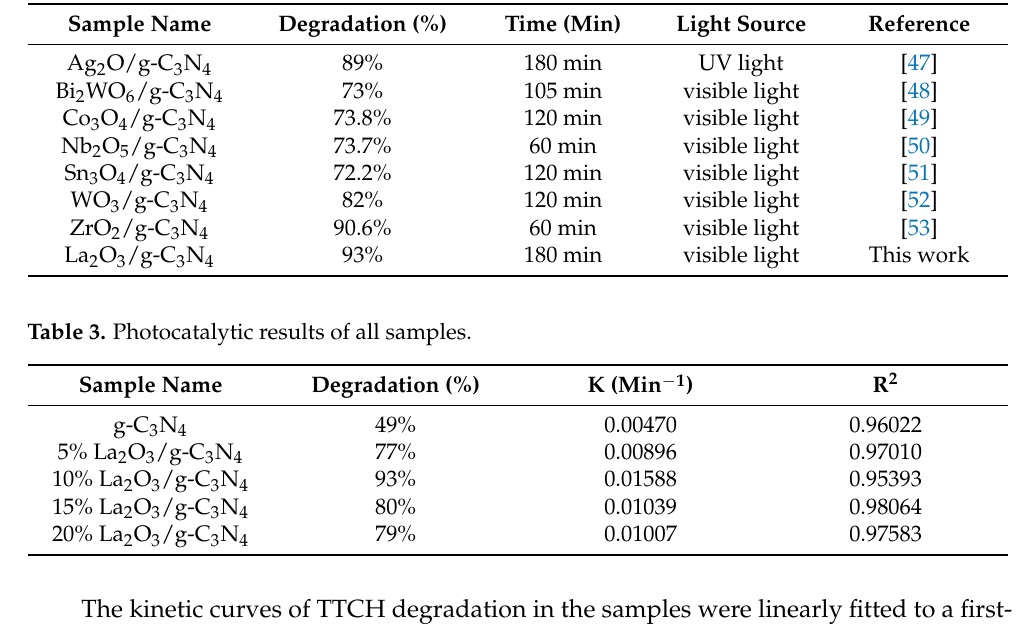
Figure 7. Photocatalytic degradation performance of samples ( a ); kinetic curves of TTCH degradation ( b ). Table 2. Comparison with other g-C 3 N 4 based heterojunction photocatalyst in TTCH degradation.